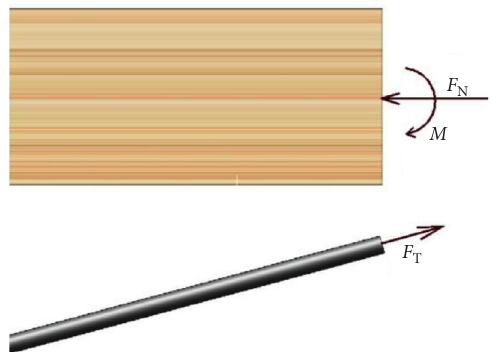
Figure 16: Internal force diagram of prestressed continuous Glulam